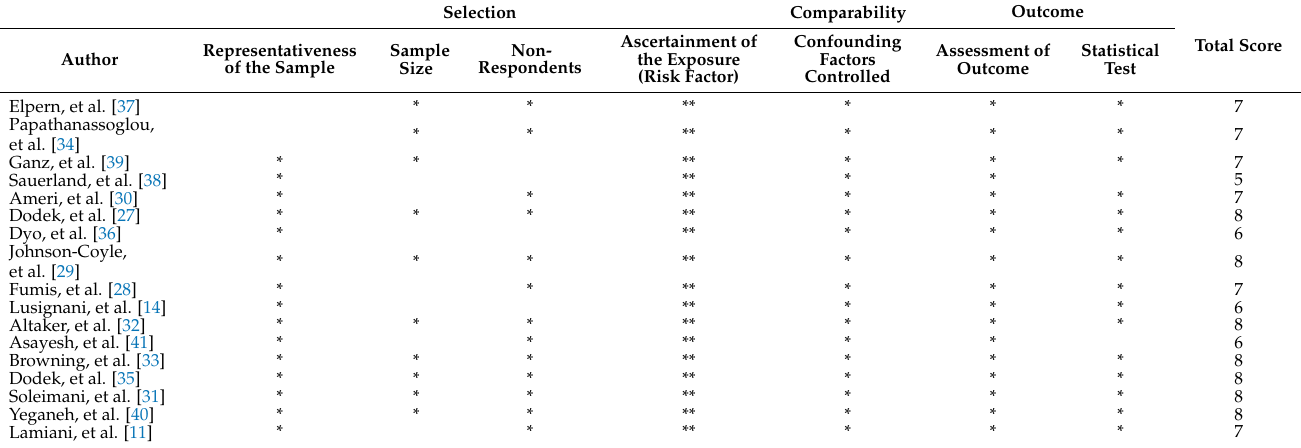
Table 4. NOS for the risk of bias and quality assessment. The explanation of * and ** is on Supple- mentary File